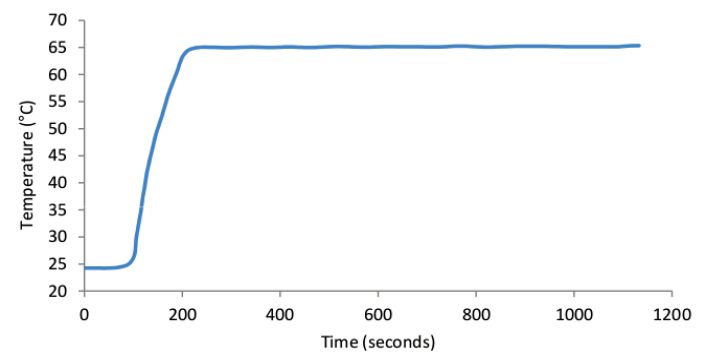
Figure 5. The temperature of the six reaction chambers is shown with error bars indicating the maximum and minimum values reached over the 5 repeat measurements. The maximum and minimum temperatures were 65.2 °C and 65.7 °C. All of the measurements were within the 60–70 °C range (shown here as the y axis range) which we had shown successful tube-based HDA amplification.